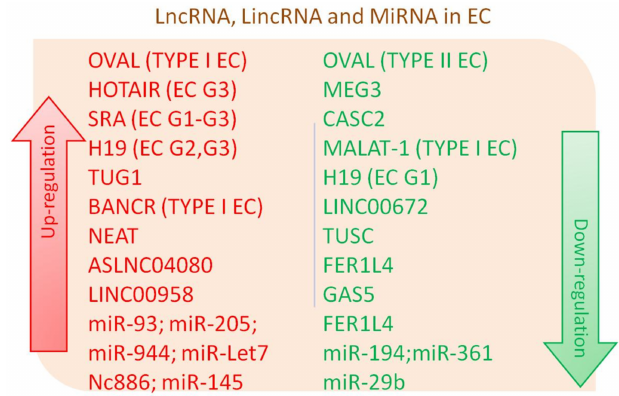
Figure 1. Differentially expressed long non-coding RNA (lncRNA), long intergenic non-coding RNAs (lincRNAs) lincRNA and micro RNAs (miRNA) in Endometrial Cancer